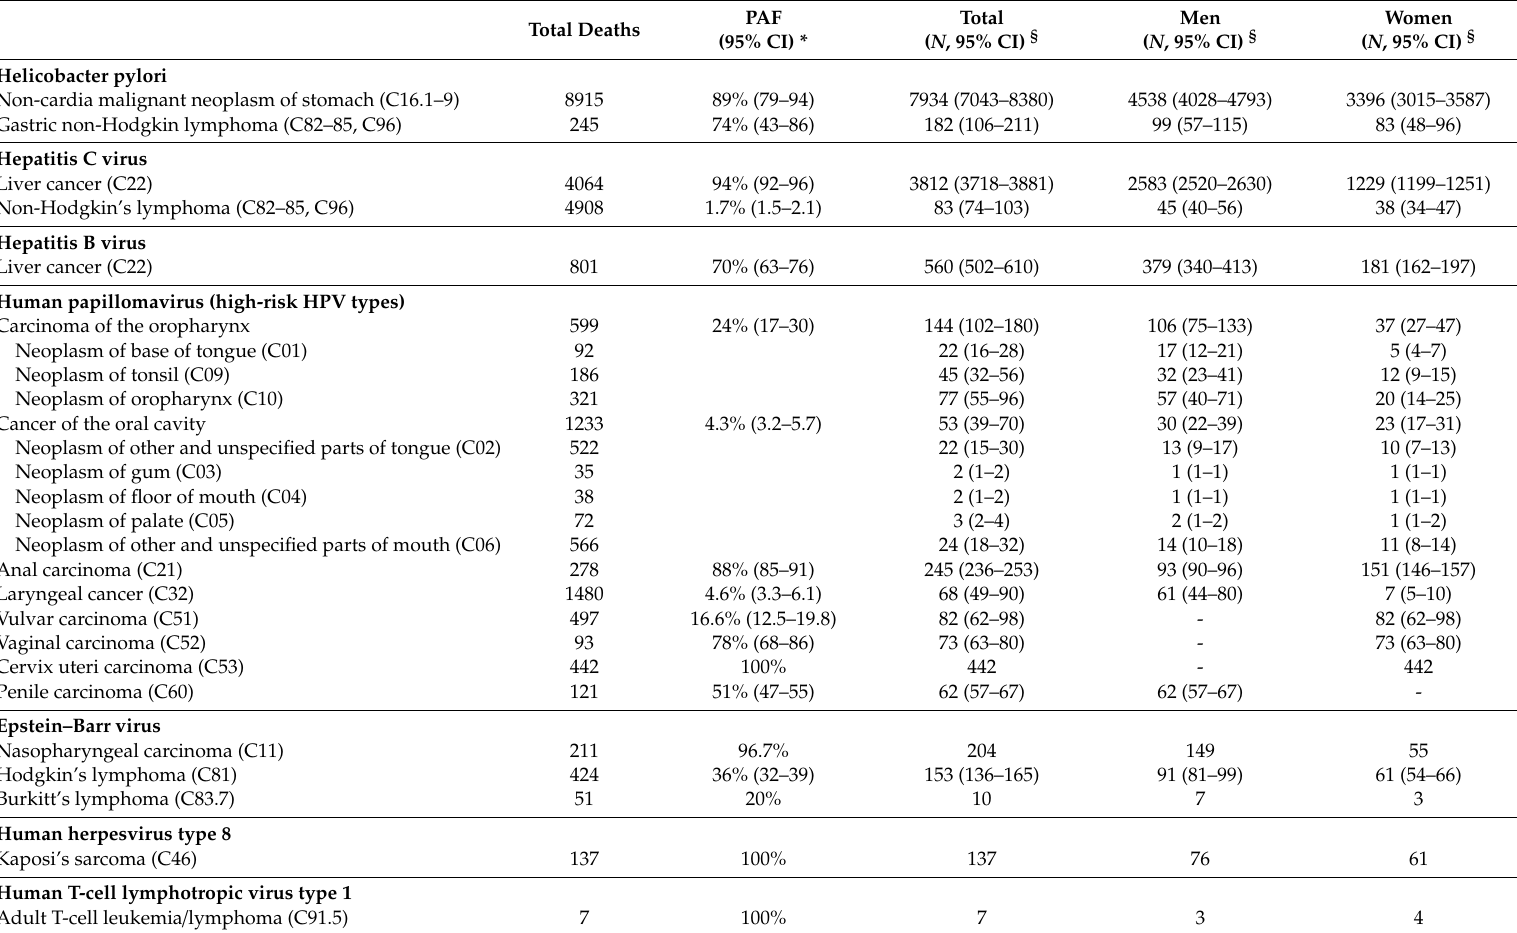
Table 1. Number of cancer deaths attributable to carcinogenic infections, by infectious agents, diagnosis (ICD-10), and sex in Italy,